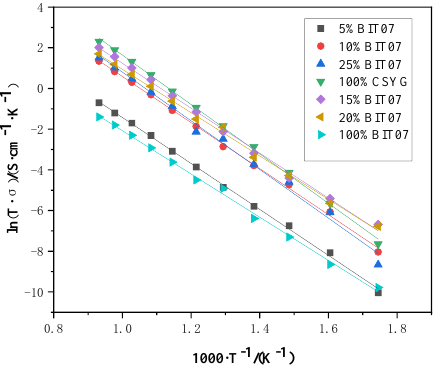
Figure 7. Arrhenius plots for total conductivity of CSYG-BIT07. The activation energies calculated from the slope of the Arrhenius plot are shown in Table 1. The activation energies of CSYG-5%BIT07, CSYG-10%BIT07, CSYG-15%BIT07, CSYG-20%BIT07, and CSYG-25%BIT07 were 0.94, 0.99, 0.89, 0.92, and 1.01 eV,